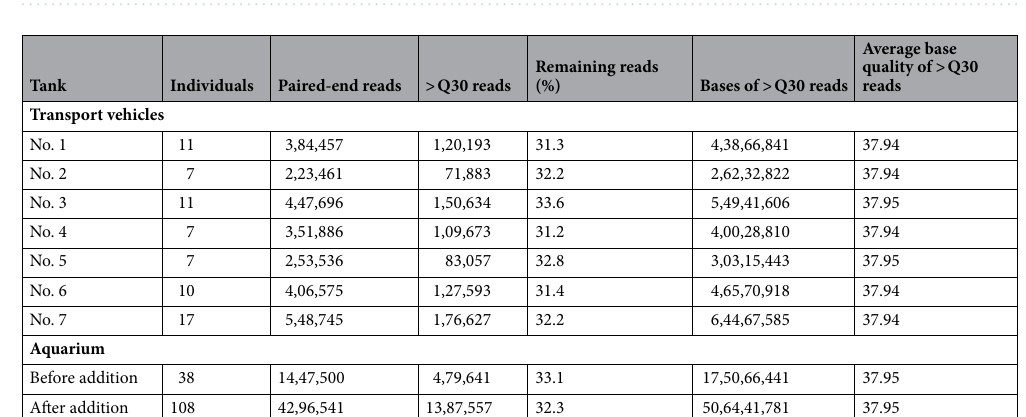
Table 1. Statistics on sequence data without the UMI tags. The number of reads and the number and percentage of reads with all bases above Q30 are shown.